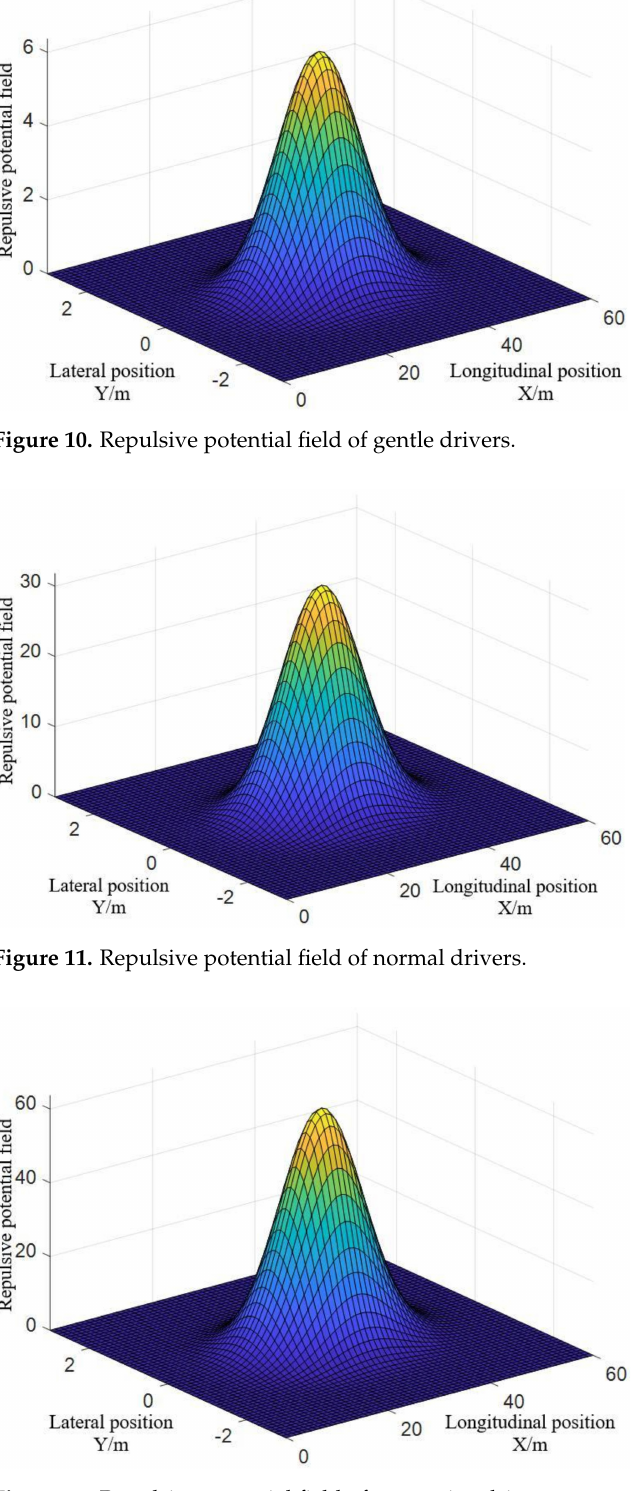
Figure 12. Repulsive potential field of aggressive